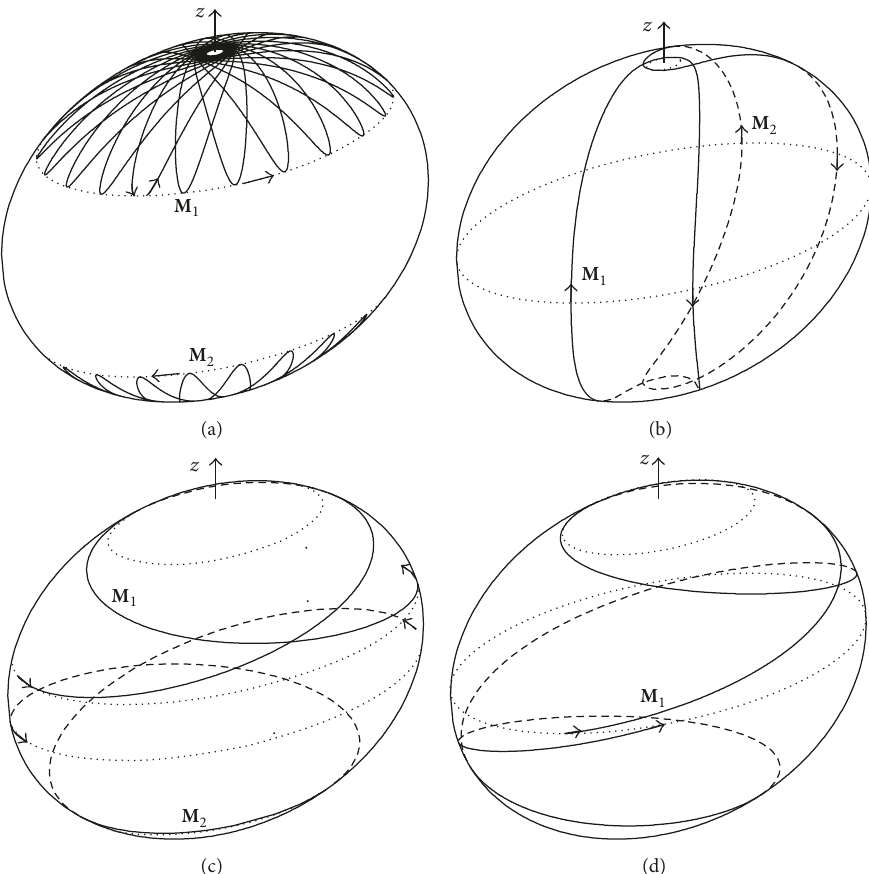
Figure 3: Dissipationless trajectories of motion of sublattice magnetizations M 1 and M 2 for an ideal antiferromagnetic particle. Nutations of the magnetization vectors with 𝑚 = 0 for 𝐸 󸀠 = 𝐸/𝐴 = (a) − 1.003 and (b) − 0.999. Nutations of the magnetization vectors with values m = (c) 0.08 and (d) 0.075 for 𝐸 󸀠 = – 0.999 . Panel (a) shows 23 initial nutations whereas panels (b)–(d) show the first nutations. Points show minimum and maximum values of projections 𝑚 1𝑧 and 𝑚 2𝑧 during